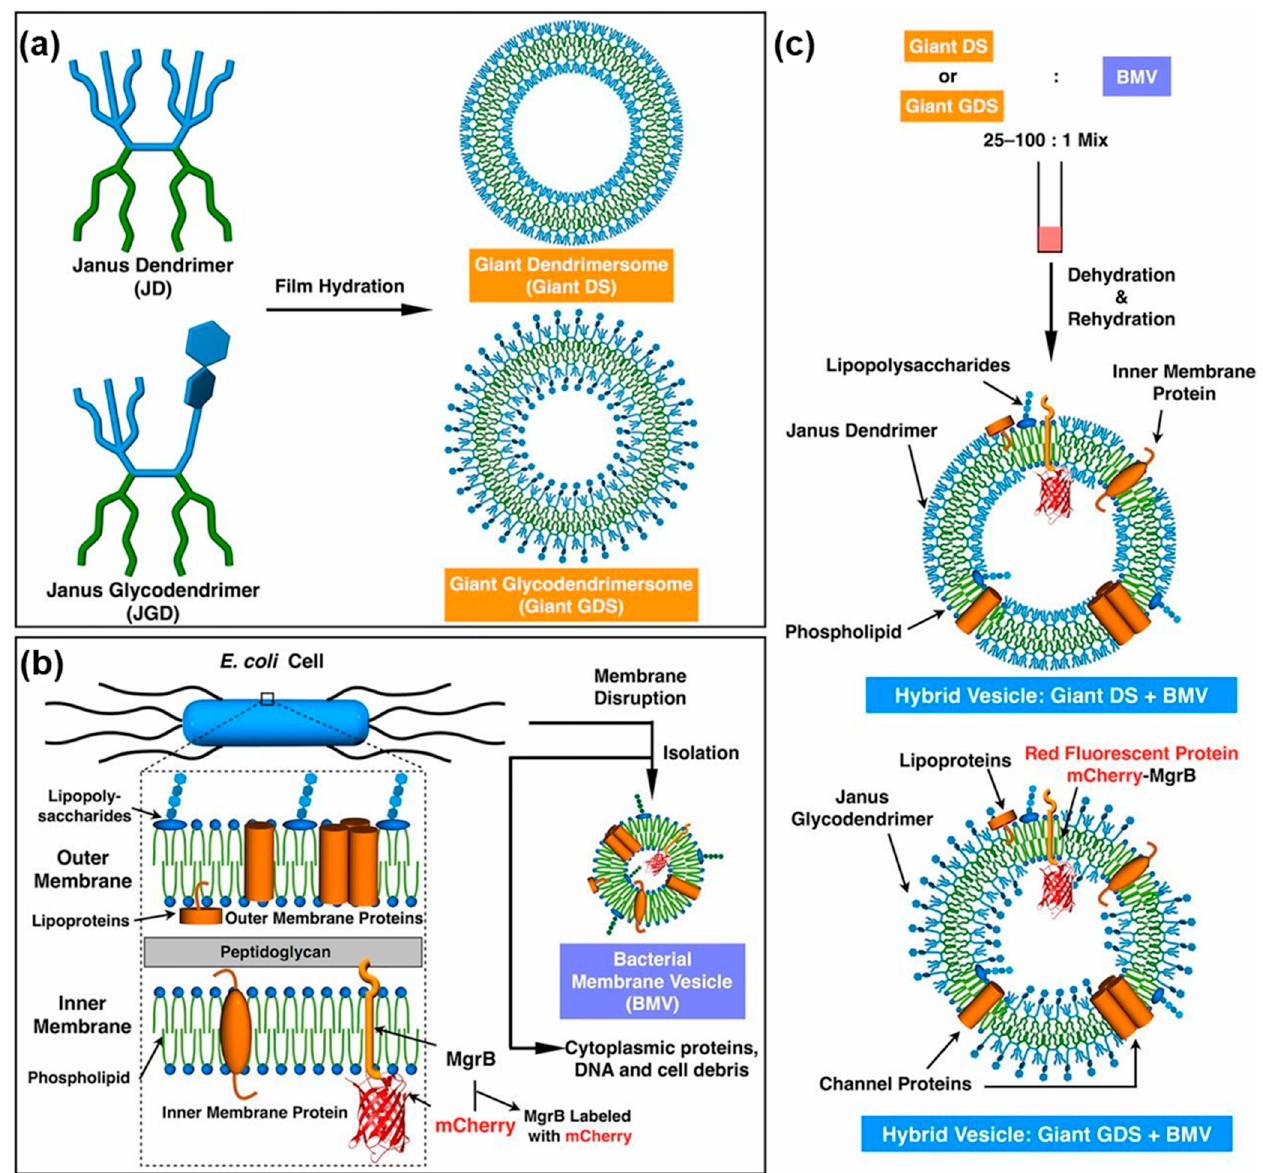
Figure 23. Illustration of ( a ) the preparation of giant DSs, ( b ) the preparation of BMV expressing YadA bacterial adhesin protein, and ( c ) coassembly of giant hybrid vesicles from giant DSs and E. coli BMV expressing YadA bacterial adhesin protein [222]. Copyright (2016) National Academy of Sciences USA.